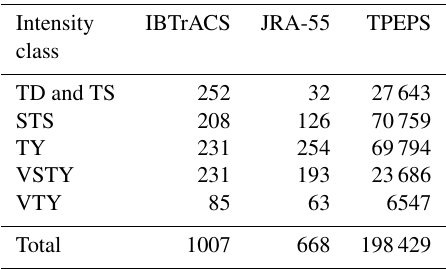
Table 6. Number of TC records in IBTrACS, JRA-55 TC event set, and TPEPS TC event set for different intensity classes. The classes are tropical depression (TD) and tropical storm (TS), severe tropical storm (STS), typhoon (TY), very strong typhoon (VSTY), and vio- lent typhoon (VTY). The intensity classes for IBTrACS are defined according to WMO (2019). The intensity classes for JRA-55 TC and TPEPS TC are derived from the WMO (2019) intensity classes by using quantile mapping of intensity records of JRA-55 TC and IBTrACS